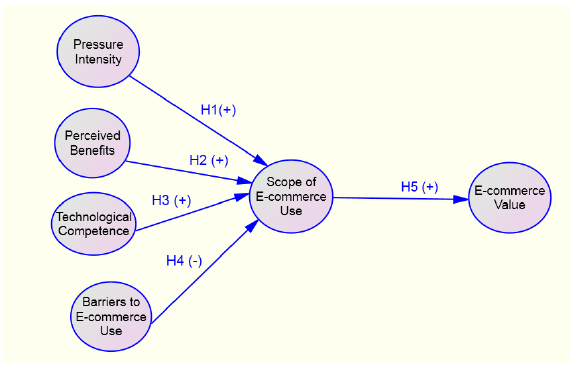
Figure 1: Initial structural model of e-commerce value